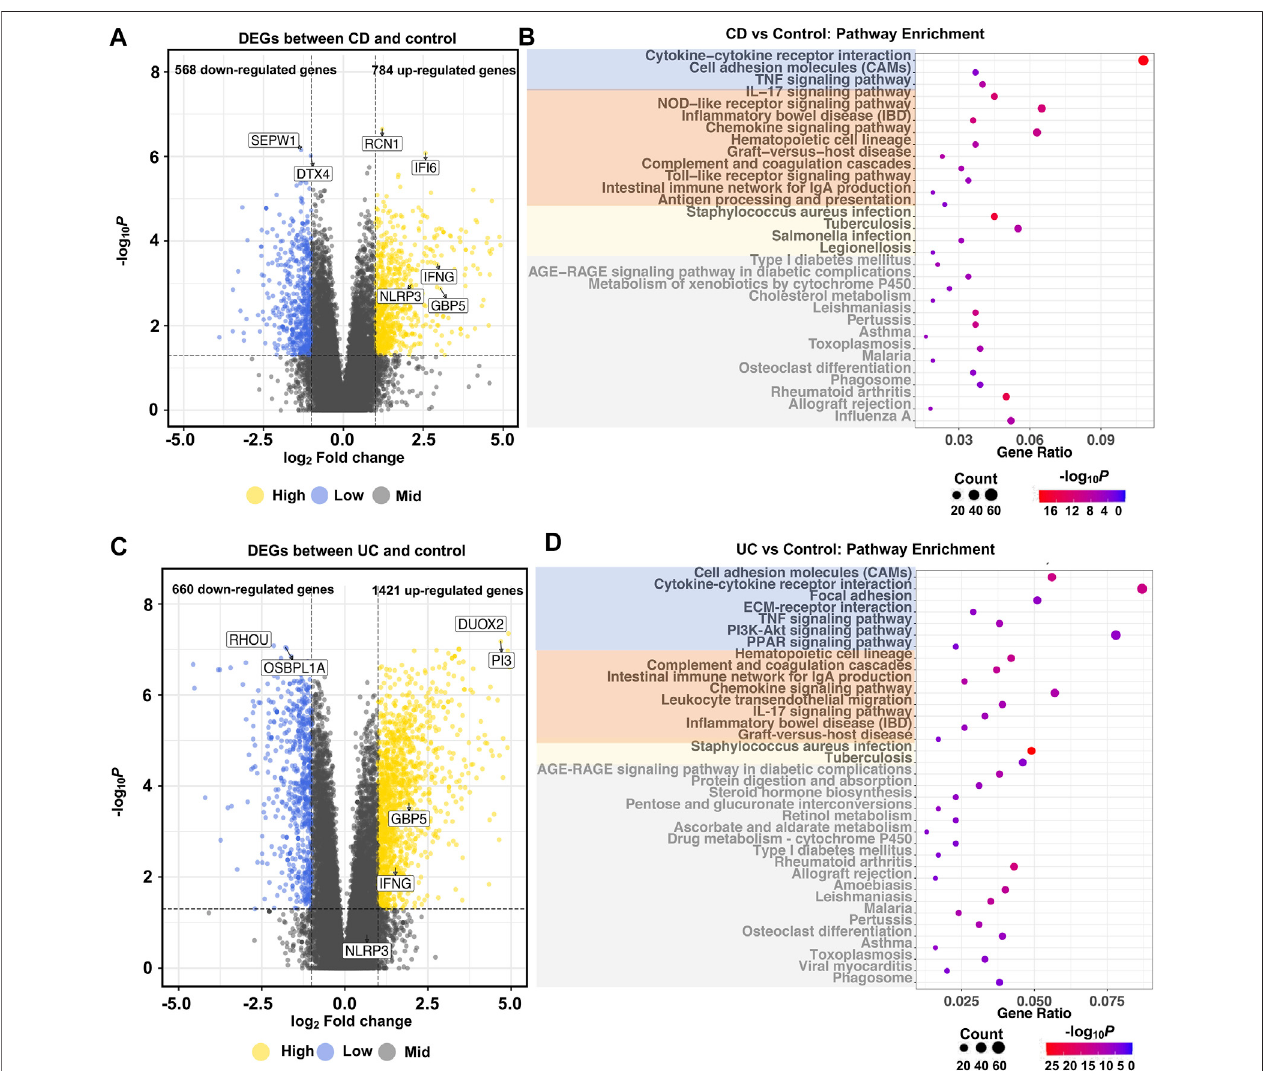
FIGURE3 | Globaltranscriptional changesof genepro fi les and KEGG pathway enrichmentin IBD. Volcano plots show the differentially expressed genesbetween CD (A) , UC (C) , and control groups (|log2Fold Change| > 1 and adjusted p < 0.05). Dot plots show the pathways signi fi cantly enriched with DEGs between CD (B) , UC (D) ,andcontrolgroups(adjusted p < 1.0e-3). N =10,15,and13fortheCD,theUC,andthecontrolgroups,respectively.Inthedotplots,signalingmoleculesinteraction and immunity- and bacterial infection-related pathways are marked by blue, orange, and yellow, respectively. Irrelevant enriched pathways are marked by